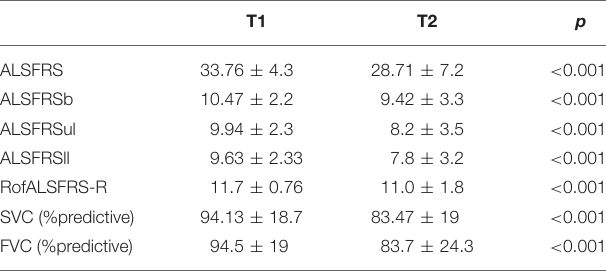
TABLE 1 | Values of the functional scores and percentage of predicted values (%) of the respiratory tests performed at study entry and 6 months after. T1 T2 p